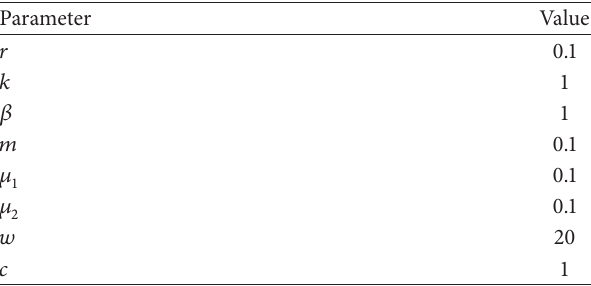
Table 2: Values of parameters for numerical simulation. Parameter